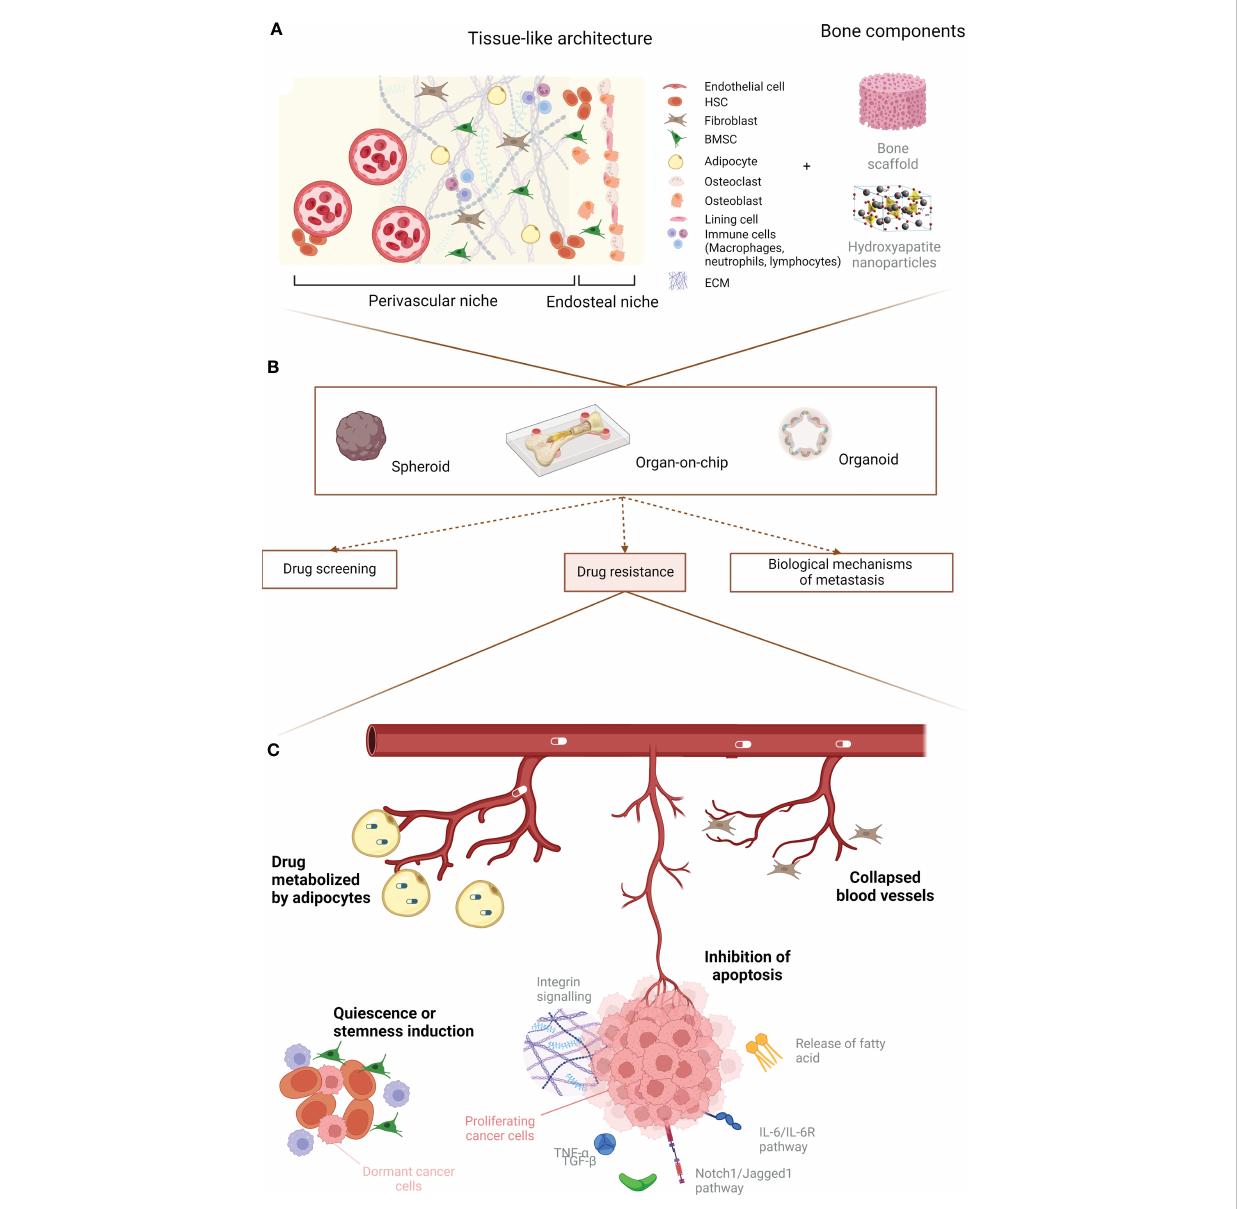
FIGURE 1 Graphical abstract. (A) Principal cellular players of the bone microenvironment. (B) Main uses for 3D in vitro models. (C) Summary of the predominant events leading to breast cancer drug resistance due to the microenvironment. Created with